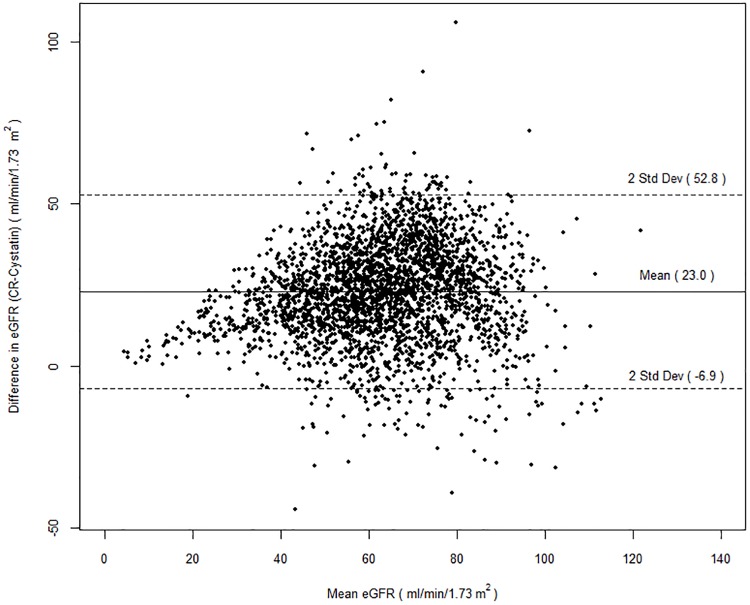
Bland-Altman plot of the difference in creatinine-based estimated glomerular filtration rate (eGFRcr) and cystatin C-based estimated glomerular filtration rate (eGFRcys) versus the mean of the two estimates.